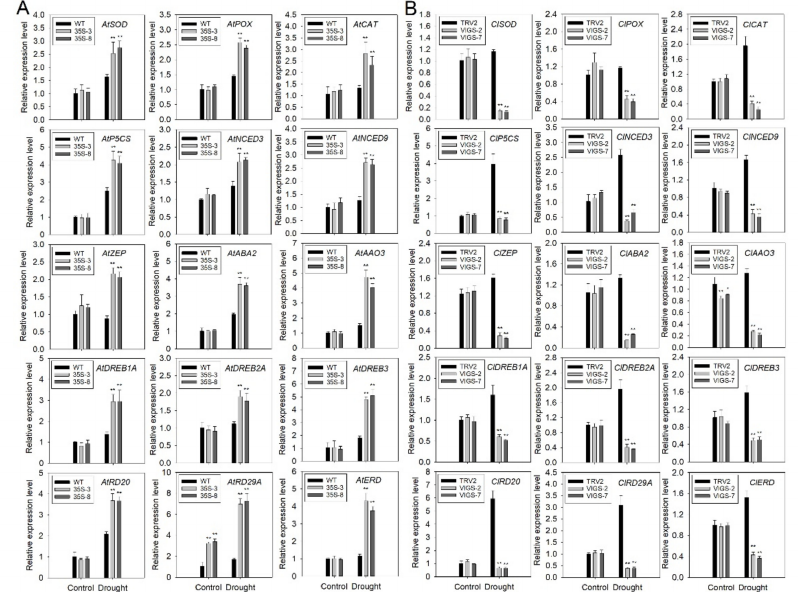
Figure 8. The expression analysis of drought-related genes in ( A ) two transgenic Arabidopsis lines (35S-3 and 35S-8) ectopic-expressing PtrbHLH66 and ( B ) two PtrbHLH66 homolog silencing lemon lines (VIGS-2 and VIGS-7) under normal growth condition (control) and drought (withheld from watering for 3 weeks) stress. The y-axis records the relative gene expression levels as calculated by the 2 −(cid:52)(cid:52) CT method. Data are shown as the means ± SD calculated from three biological replicates. Significant expression differences between the control and transgenic plants at the p < 0.05 and p < 0.01 levels are indicated by single (*) and double asterisks (**), respectively, according to Student’s t